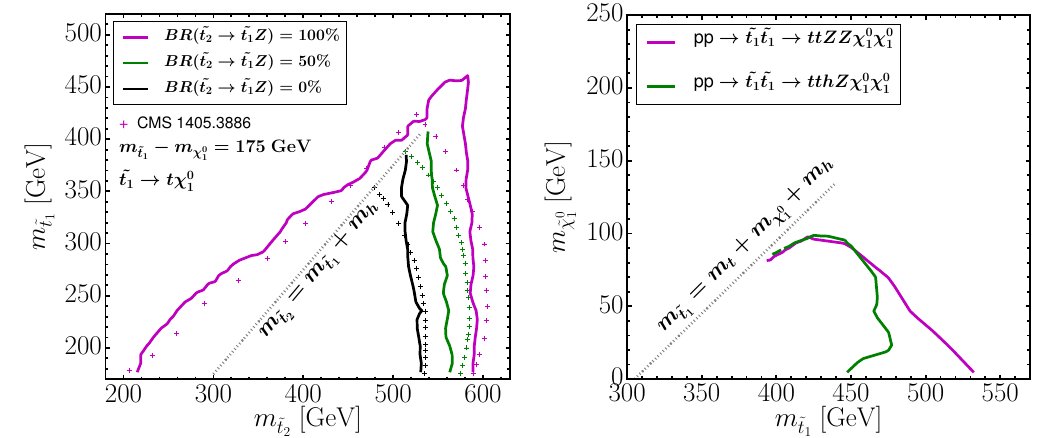
Figure 3 . The comparison of 95% C.L. upper limits between CMS results (\+" symbol lines) and our simulations (solid lines) for the LHC ~ t 2 pair production, with combined ~ t 2 ~ t 0 , assuming BR (~ t 2 1 ! t(cid:31) 1